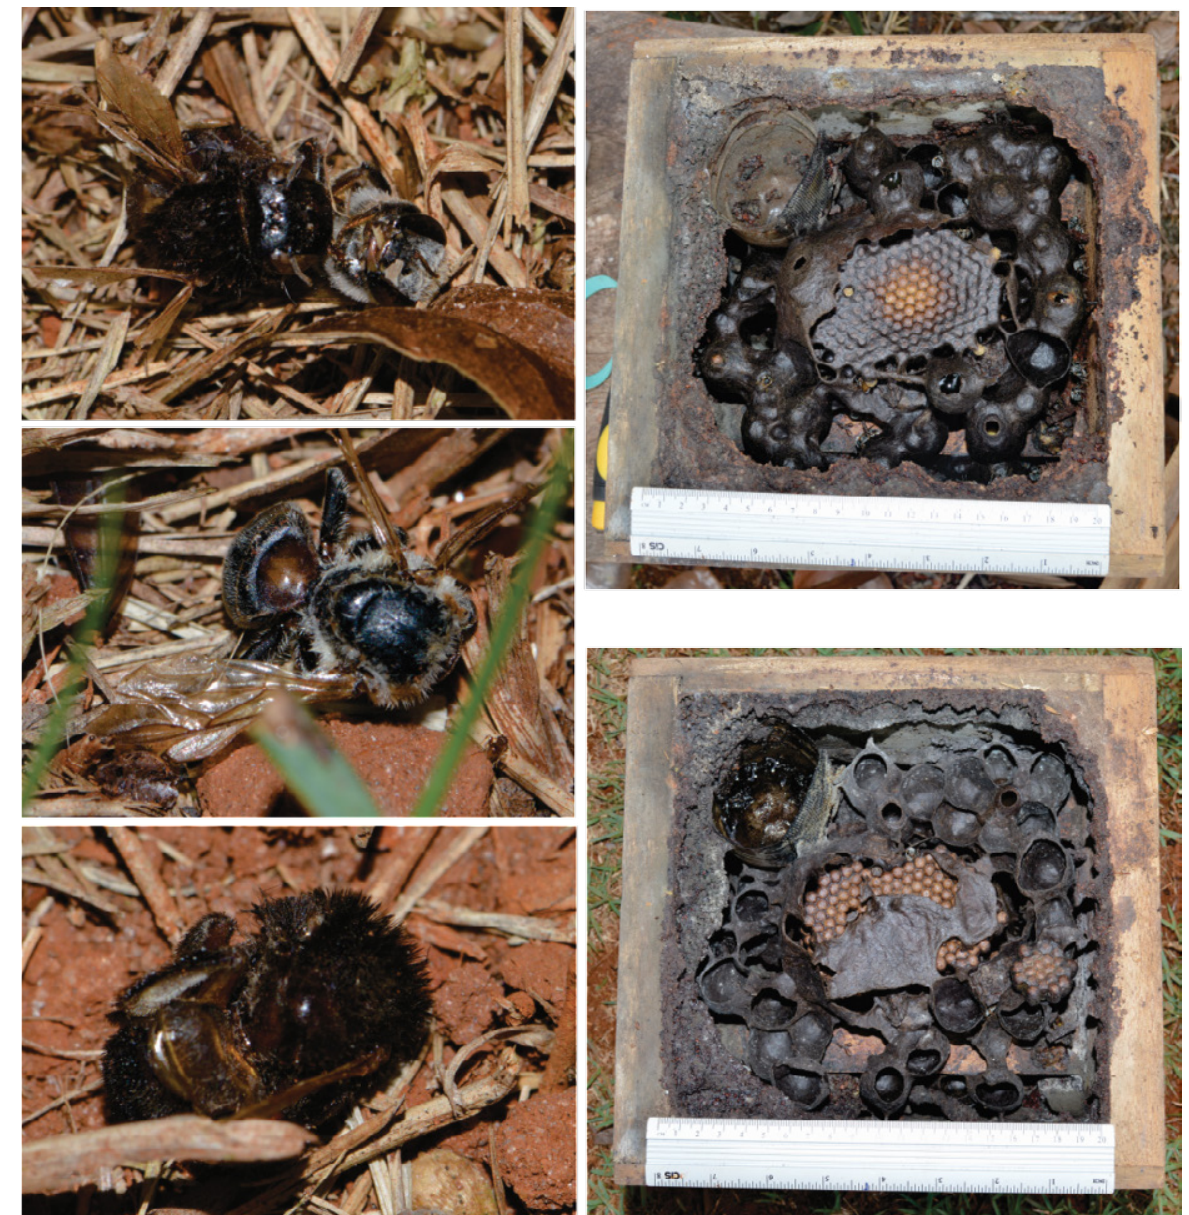
Fig 2 . Upper left: M elipona fuliginosa and M elipona fasciculata workers dead, grabbing one another. Center left: decapitated M. fasciculata worker. Lower left: decapitated M. fuliginosa worker. Upper right: M. fasciculata colony one month before the robbing. Lower right: the same colony after robbing showing empty